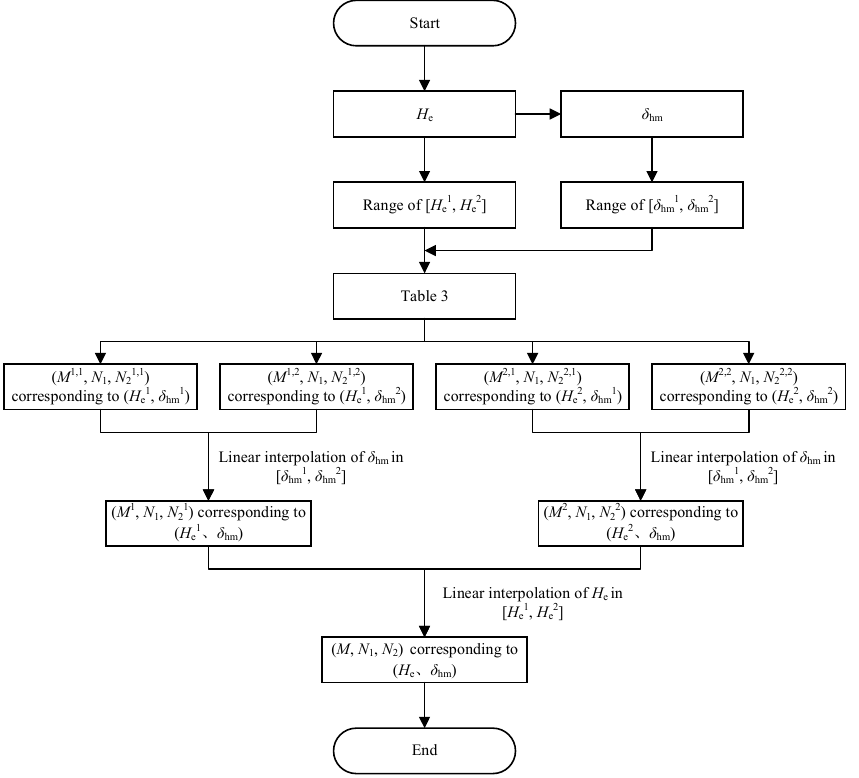
Figure 12. Flow chart for predicting the scope of the influenced zone of deep excavation under any H e and δ hm conditions.